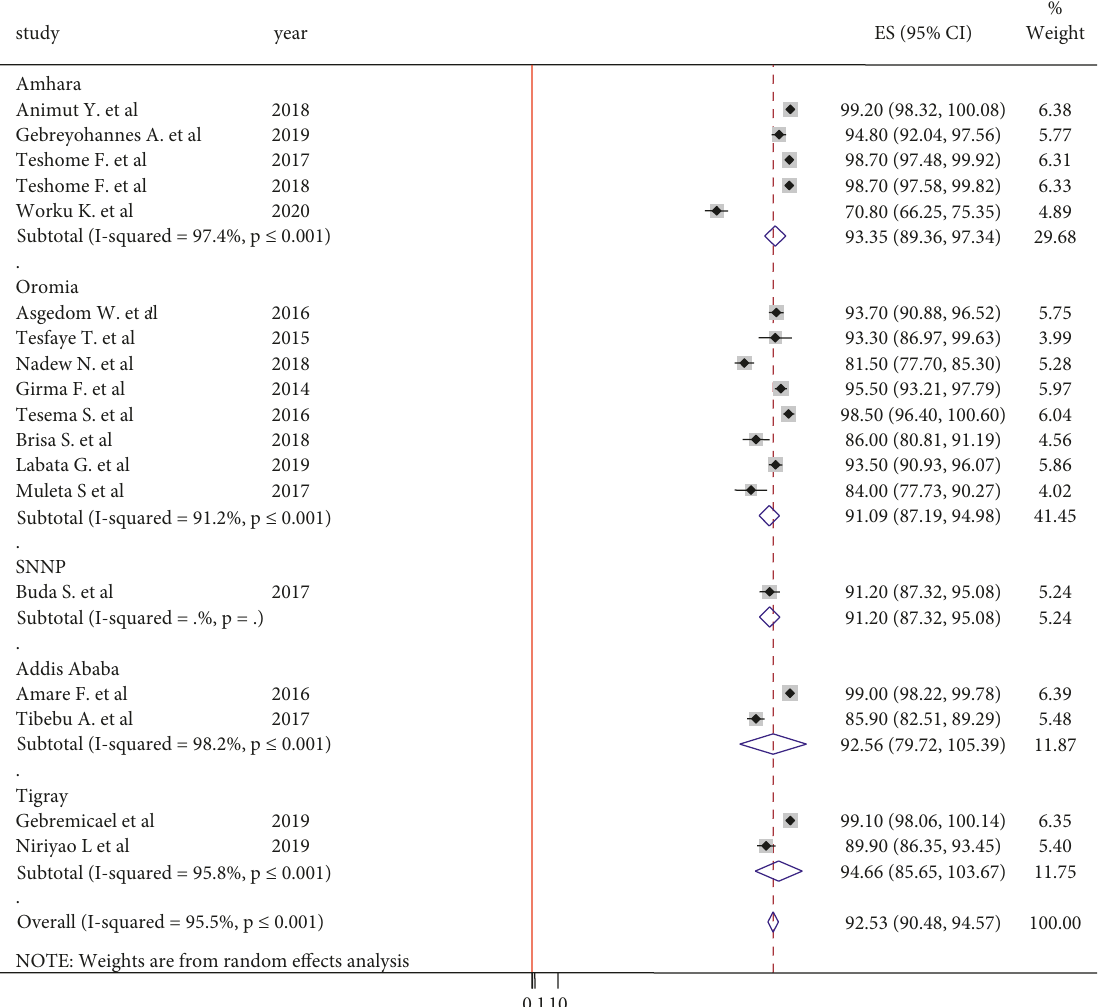
Figure 7: Forest plot on adherence to smoking abstinence among hypertensive